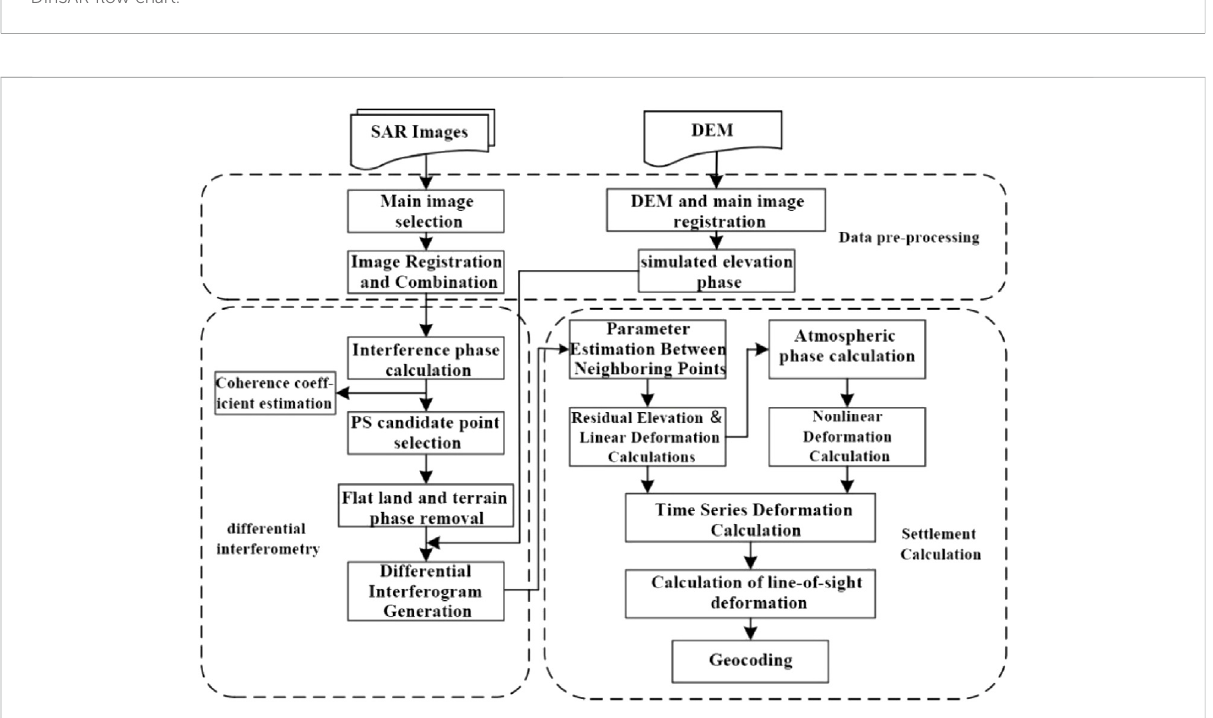
FIGURE 4 DInSAR fl ow chart.